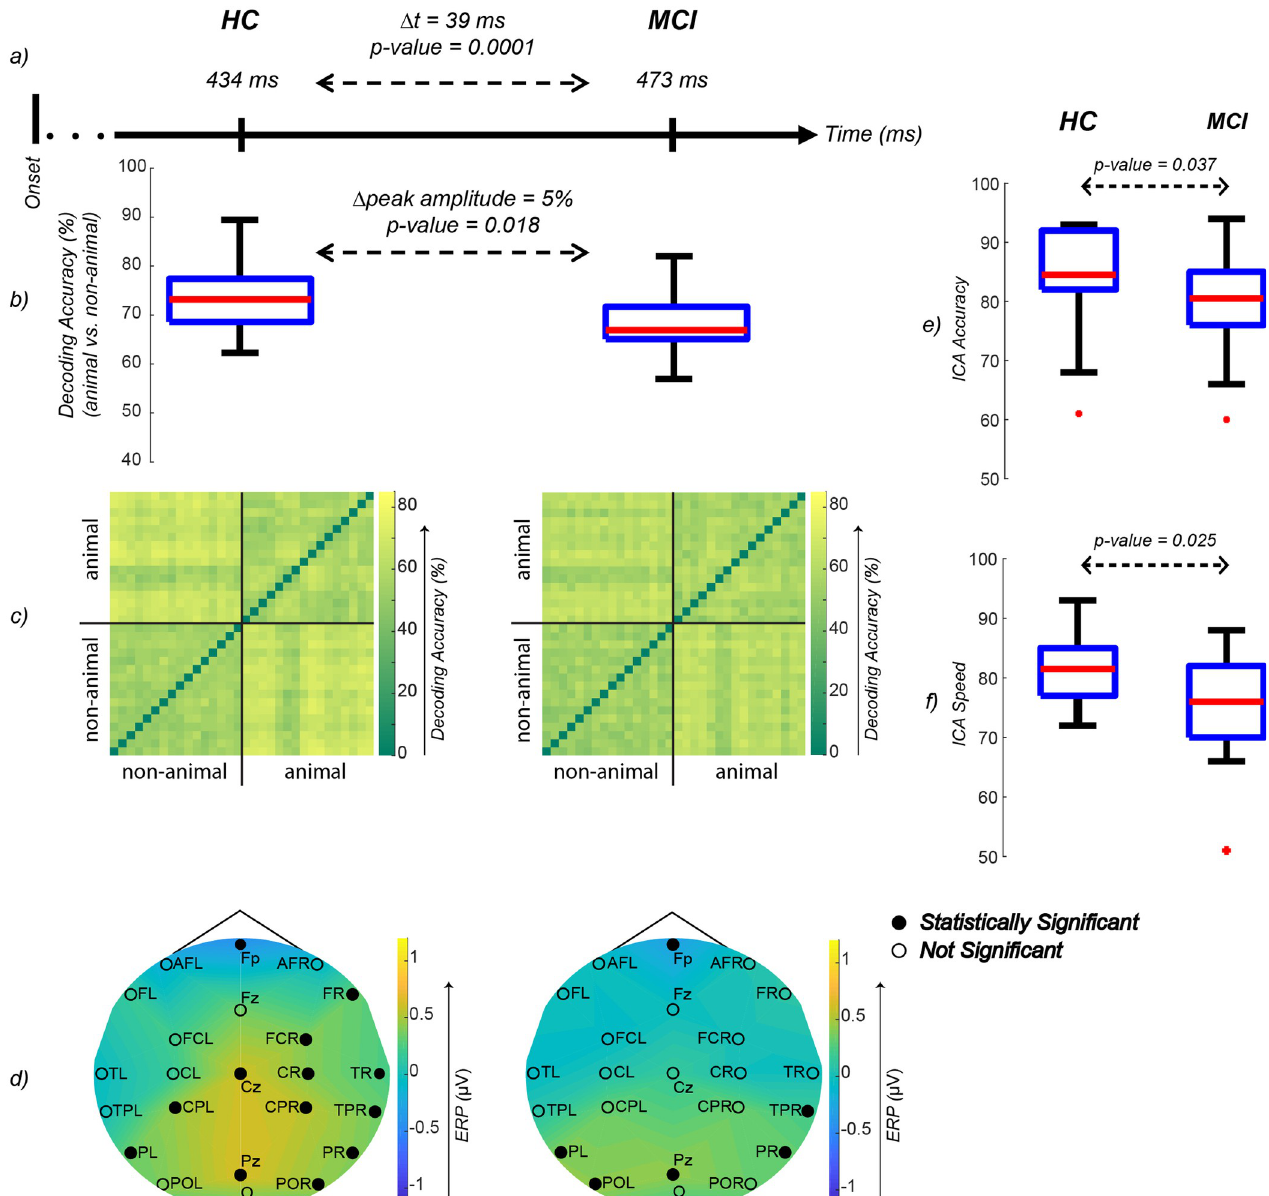
Fig 5. a) Median of animal vs. non-animal decoding accuracy peak time-points. 10000 bootstrap resampling without replacement of participants was applied to measure the differences between HC and MCI. The difference of medians of HC and MCI peaks is 39 ms (p-value = 0.0001; One-sided bootstrap test) b) Box-plot of animal vs. non-animal EEG decoding peak amplitude. The difference of HC and MCI amplitude medians is 5% (p-value = 0.018; rank-sum). c) Mean EEG RDM of participants at the time of animal vs. non-animal decoding peak. No significant difference was observed between the RDMs (permutation test). d) Mean ERP of participants at the time of animal vs. non-animal decoding peak. The black dots indicate significant activation in channels of the specified region (FDR-corrected at 0.05 sign-rank). No significant difference between the ERP of HC and MCI was observed (FDR-Corrected at 0.05 rank-sum). e) Box- plot of the ICA test accuracy (results of the behavioral ICA, taken on iPad). A significant difference is observed between HC and MCI (p-value = 0.037; rank- sum). f) Box-plot of the ICA test speed (results of the behavioral ICA, taken on iPad). A significant difference is observed between HC and MCI (p- value = 0.025; rank-sum). Fp: prefrontal; AFL: left anterior frontal; AFR: right anterior frontal; FL left frontal; Fz: midline frontal; FR: right frontal; FCL: left fronto-central; FCR: right fronto-central; TL: left temporal; CL: left central; Cz: midline central; CR: right central; TR: right temporal; TPL: left temporo- parietal; CPL: left centro-parietal; CPR: right centro-parietal; TPR: right temporo-parietal; PL: left parietal; PR: right parietal; POL: left parieto-occipital; Pz: midline parietal; POR: right parieto-occipital; O: occipital.